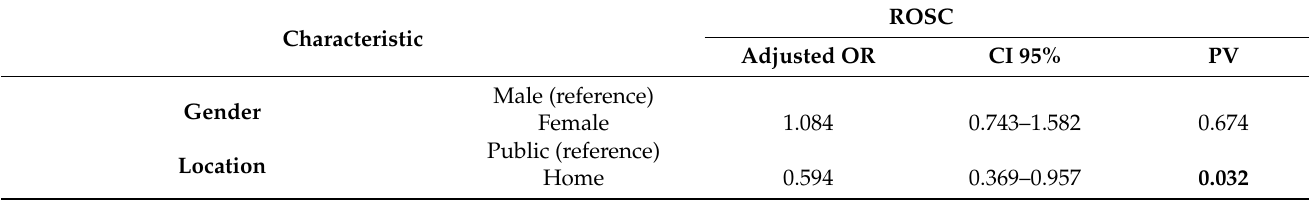
Table 2. Adjusted ROSC outcome according to patients’ characteristics and prehospital and hospital